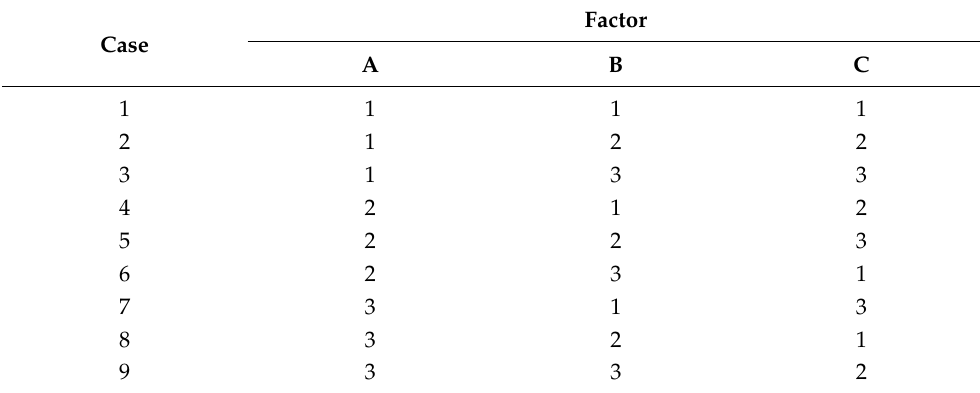
Table 3. L 9 (3 3 ) orthogonal